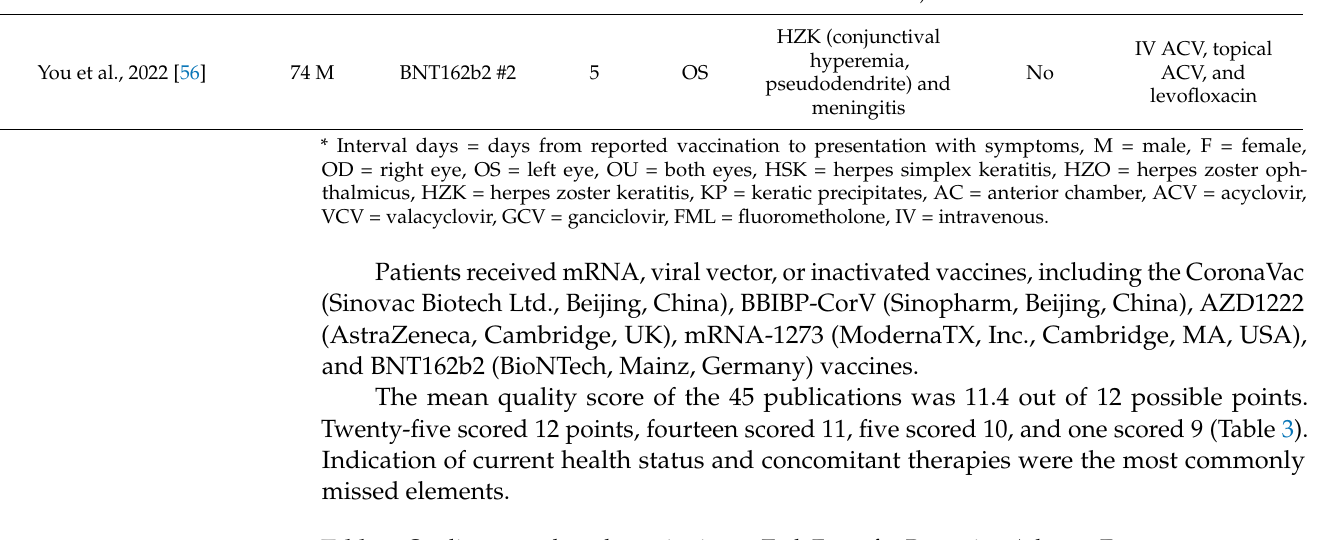
Table 3. Quality scores based on criteria per Task Force for Reporting Adverse